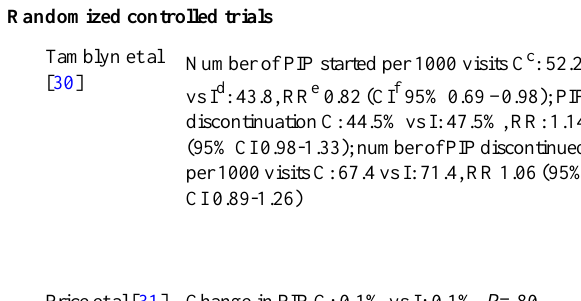
Table 3. Results of the included studies including changes in potentially inappropriate prescriptions or medications (N=16). PIP a - or PIM b -related outcomesStudy Randomized controlled trials